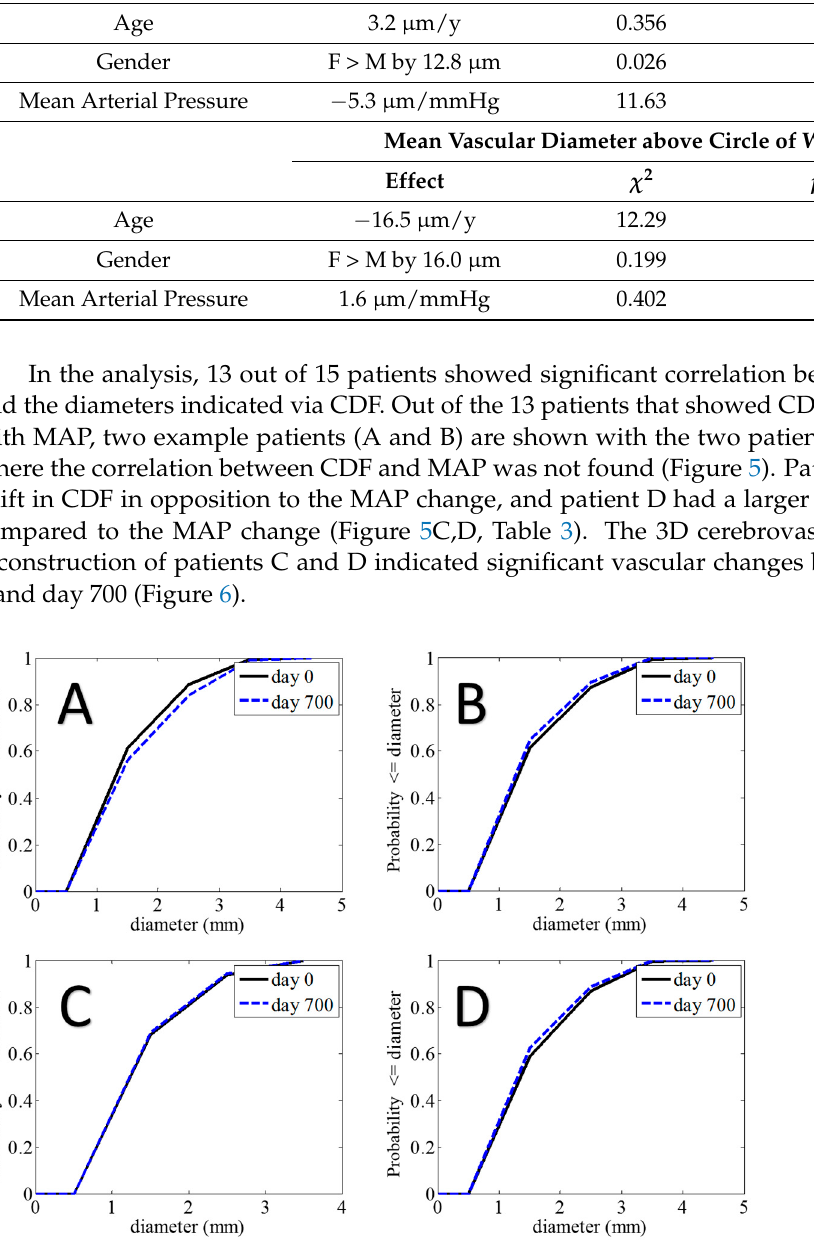
98.7 Figure 6. Applying a 3D growing algorithm to the volume of binary segmented images allows for visualization of the automatically segmented MRA data. Day 0 of patient C (top left). Day 700 of patient C (top right). Day 0 of patient D (bottom left). Day 700 of patient D (bottom right). The correlation between the CDF and MAP was not found in these patients. Some apparent differences between vascular constructions in areas below the circle of Willis are highlighted.